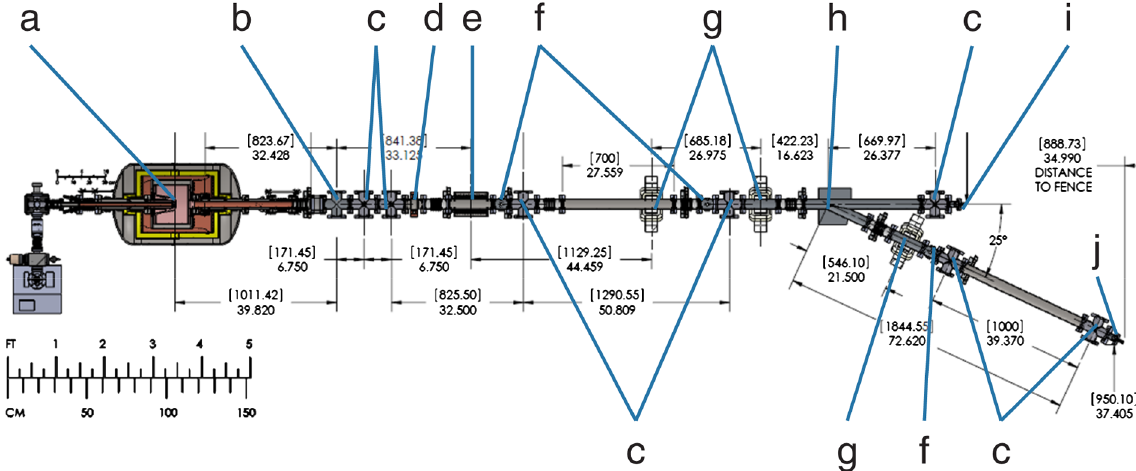
FIG. 9. Diagnostic beam line, showing (a) cavity, (b) laser cross, (c) diagnostics stations, (d) capacitive beam pickup, (e) solenoid, (f) BPMs, (g) quadrupole magnets, (h) dipole magnet, (i) end-of-line UV-transmissive window, and (j) fast Faraday